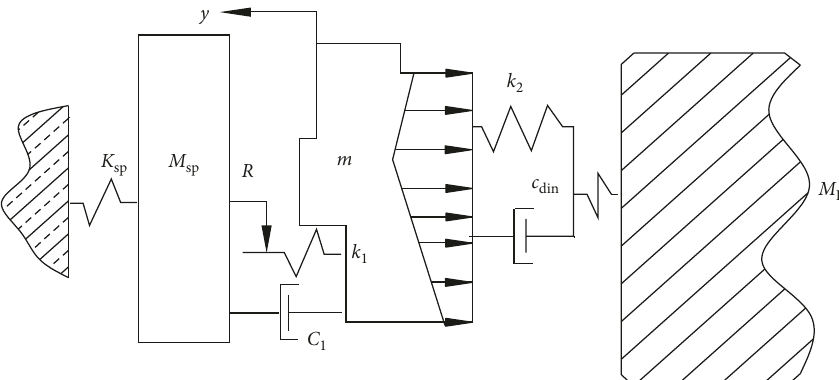
Figure 1: Model of stationary ring displacement response in frequency domain analysis of noncontact mechanical